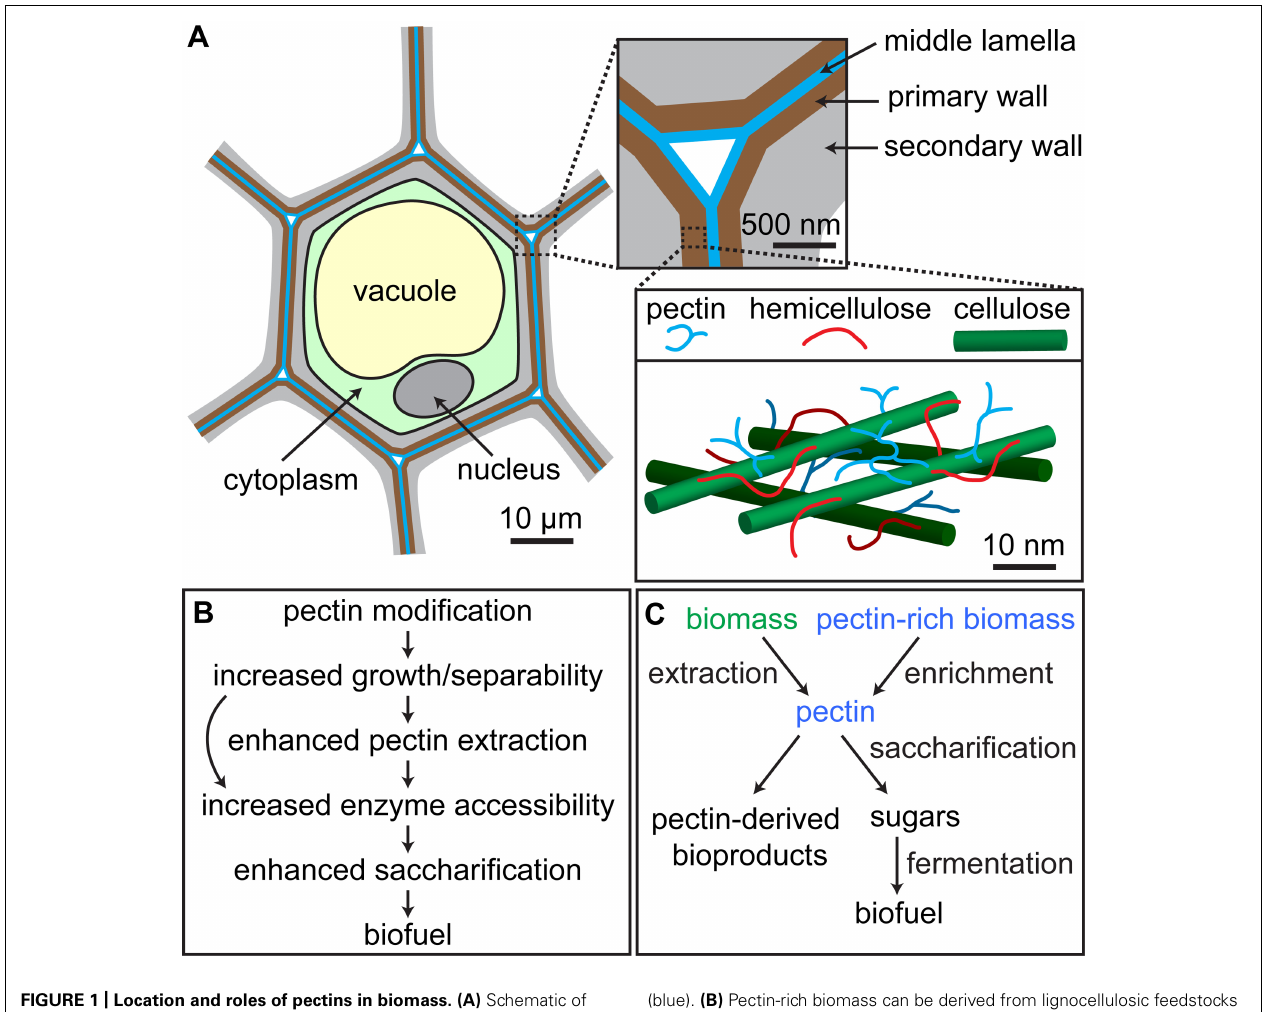
FIGURE 1 | Location and roles of pectins in biomass. (A) Schematic of plant cell showing arrangement of cell walls; pectin is abundant in the primary walls synthesized by growing cells (brown) and the middle lamella that adheres adjacent cells (blue), but is also present in lower amounts in secondary walls produced after the cessation of growth (gray). Inset at lower right is a simplified model of the primary cell wall showing one possible arrangement of cellulose microfibrils (green), hemicellulose (red), and pectin